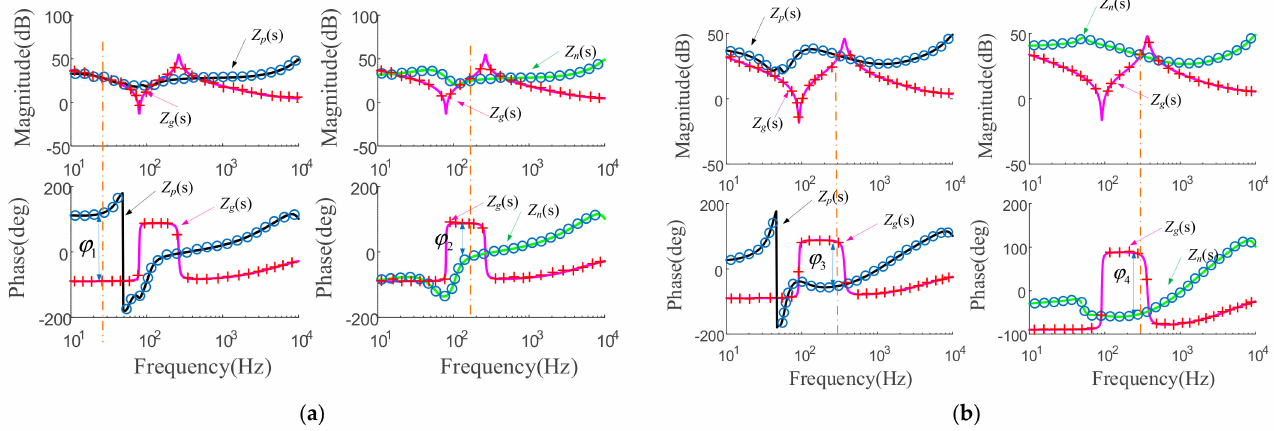
Figure 14. Experimental results of the impedance measurement ( a ). Before impedance reshaping control, ( b ) after the impedance reshaping